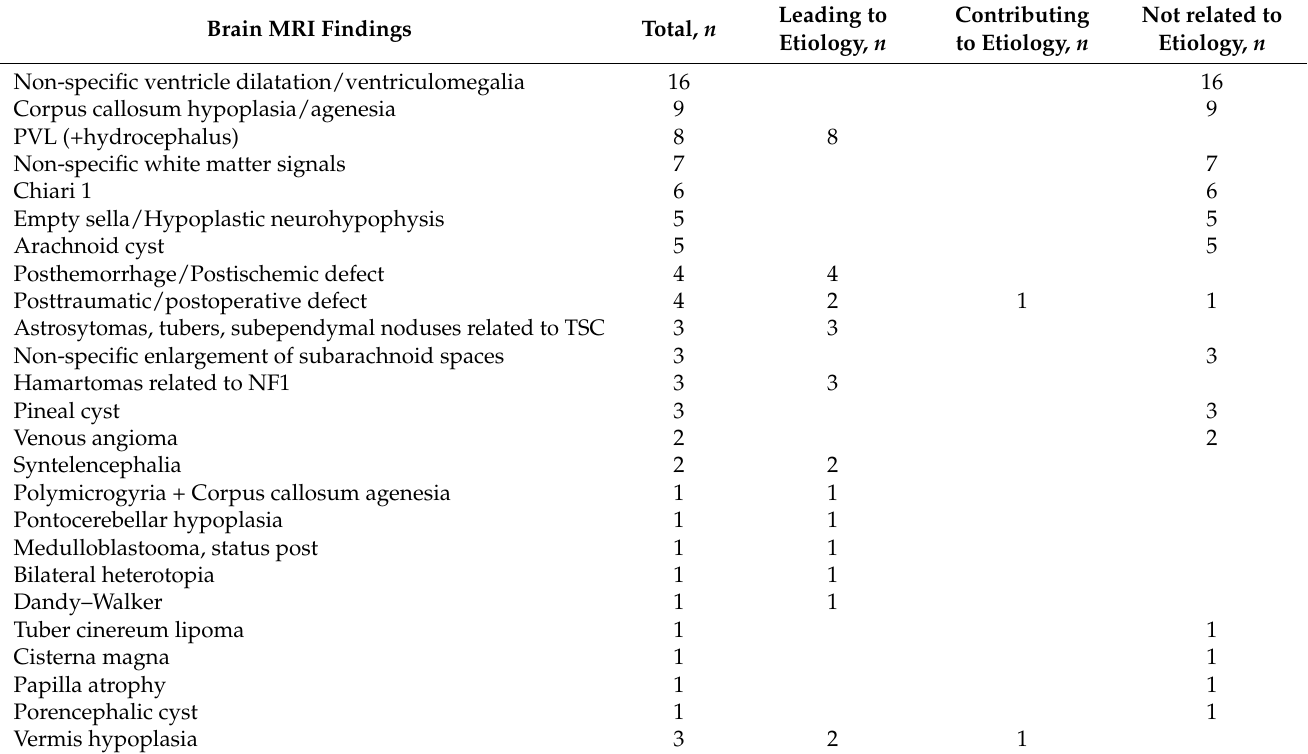
Table 4. Abnormal brain MRI findings categorized as findings leading to etiology, contributing to etiology, and not related to etiology